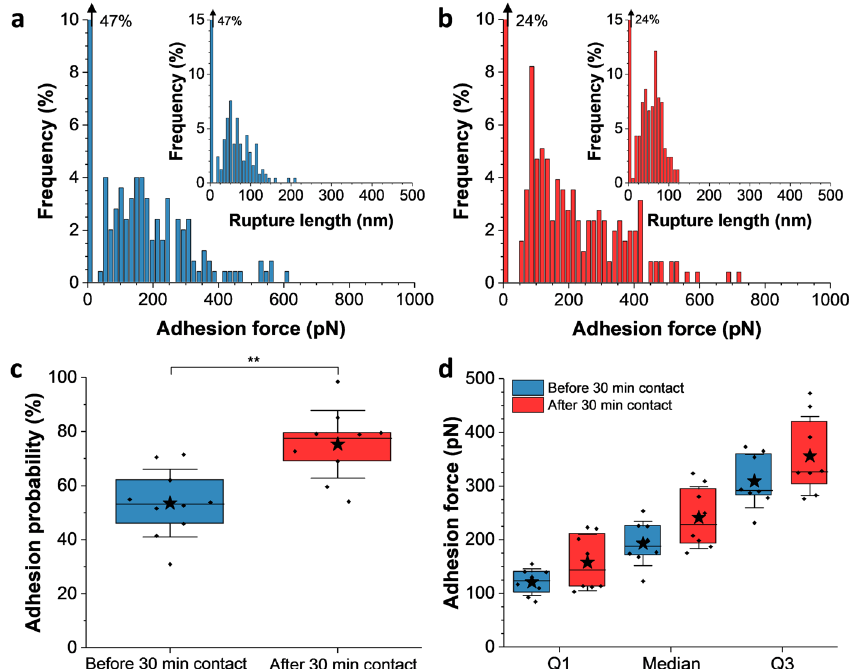
Fig. 4 Extended cell – cell contact increases agglutination forces. Maximum adhesion force histograms a before and b after a prolonged contact of 30 min between cells, obtained by recording force – distance curves in PBS between a representative MAT a – MAT α cell pair pretreated with pheromones, at an applied force of 1 nN, with a probing time of 1 s and a retraction velocity of 1000 nm s − 1 . Insets show the corresponding distribution of rupture lengths. Percentage on the top left corner stands for the non-adhesive events. c Box plots of the adhesion probability between MAT a and MAT α cells before and after 30 min contact ( N = 10 independent cell pairs). d Box plots of the adhesion forces reached at diverse quartiles (Q1: 25%, median: 50% and Q3: 75% of the adhesive population) before and after 30 min contact ( N = 8 independent cell pairs), suggesting a slight shift toward higher force populations. Stars are the mean values, lines the medians, boxes the 25 – 75% quartiles, and whiskers the SD from N = 8 independent cell pairs. Student ’ s t test: ** p ≤